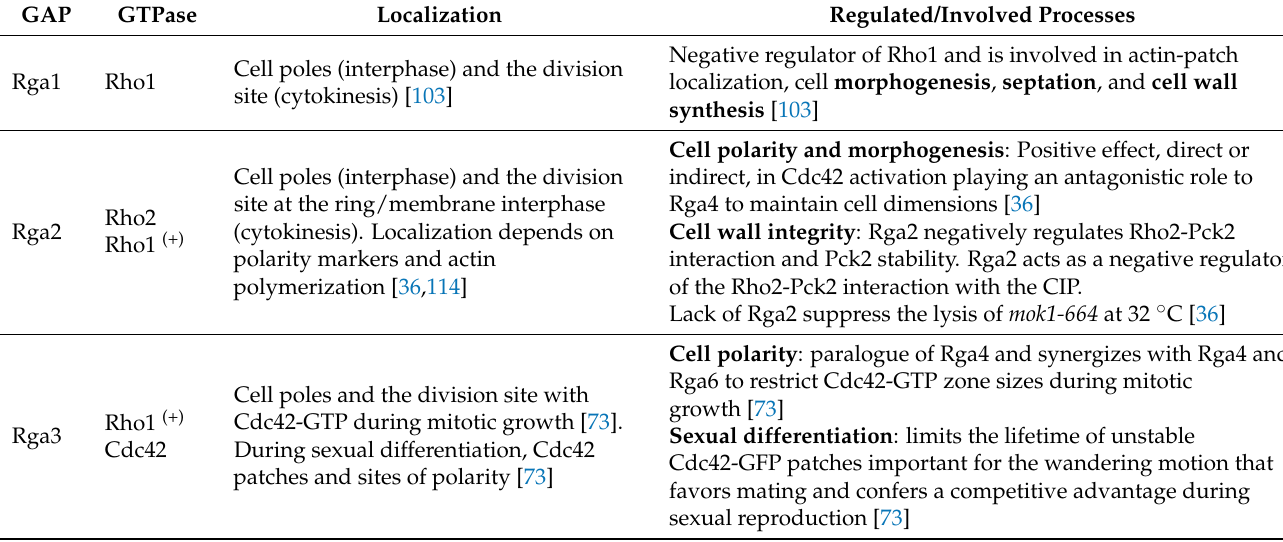
Table 3. GTPase activating proteins (GAPs) for Rho GTPases in fission